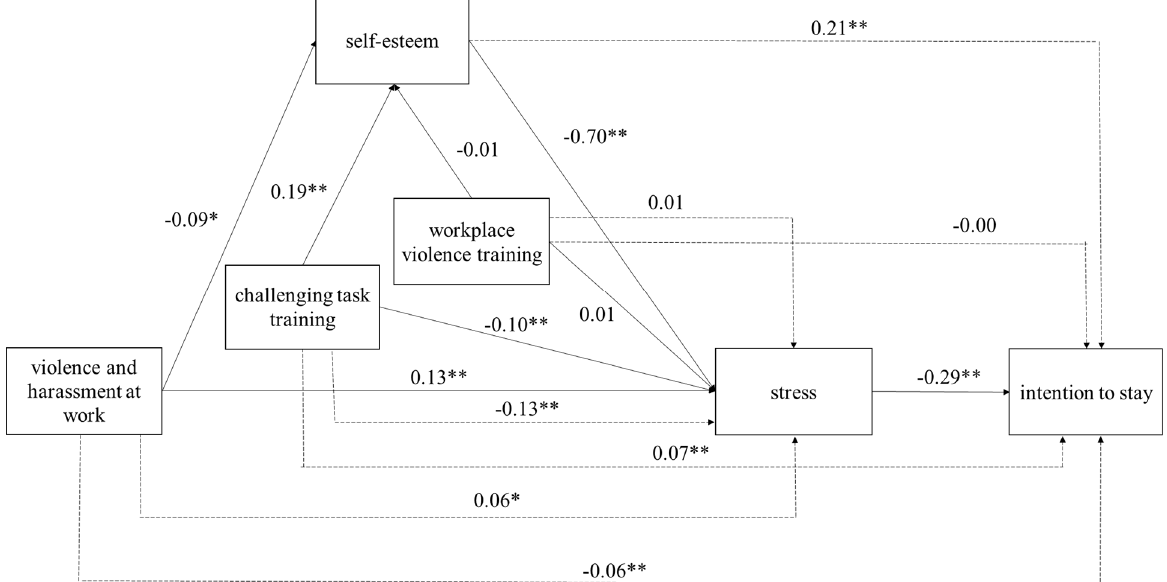
Figure 2. Direct effects between intention to stay, violence and harassment, challenging task train ‐ ing, workplace violence training, self ‐ esteem, and stress. All coefficients are standardized. The con